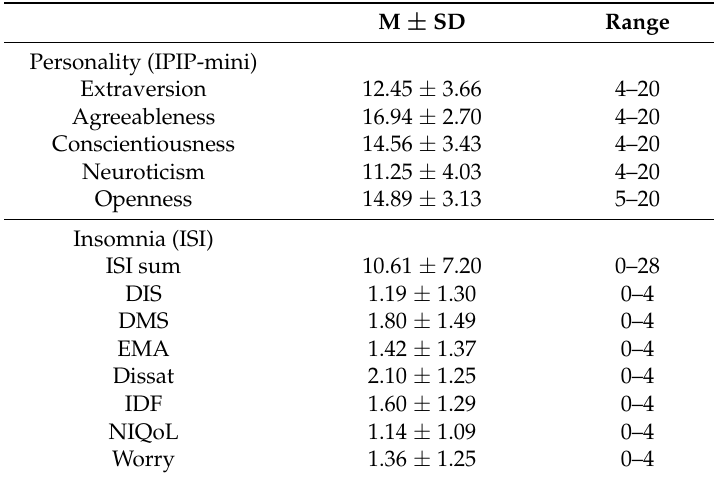
Table 1. Mean (M), standard deviation (SD) and observed range for the five personality traits, the Insomnia Severity Index (ISI) sum score and the separate ISI